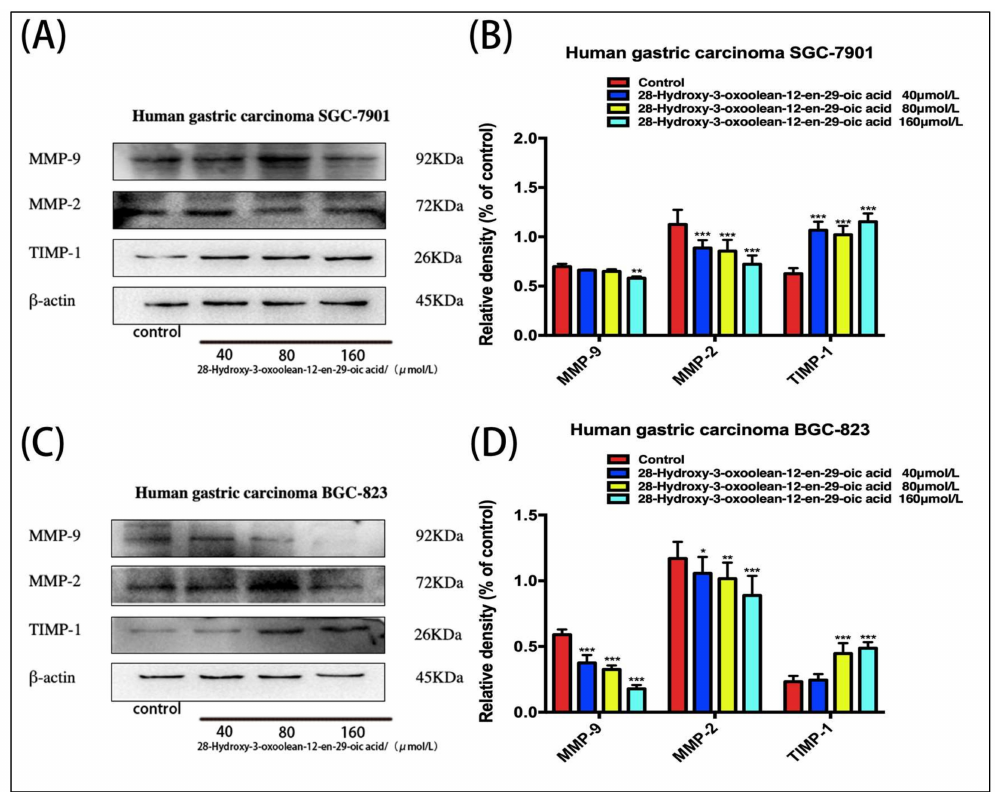
Figure 5. ( A,C ) Changes in the expression levels of matrix metalloproteinases (MMPs) following treatment with 28-hydroxy-3-oxoolean-12-en-29-oic acid for 24 h were assessed by Western blotting. ( B,D ) The band intensities of TIMP-1,MMP-9 and MMP-2 relative to untreated control cells were quantified upon normalizing to β -actin expression, and are expressed as the mean ± standard deviation of three independent